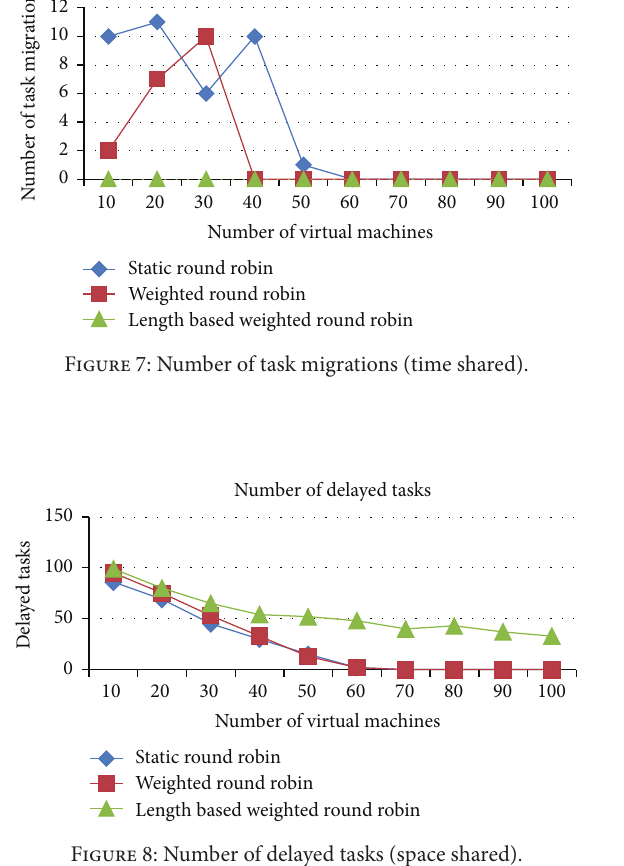
Figure 8: Number of delayed tasks (space shared).